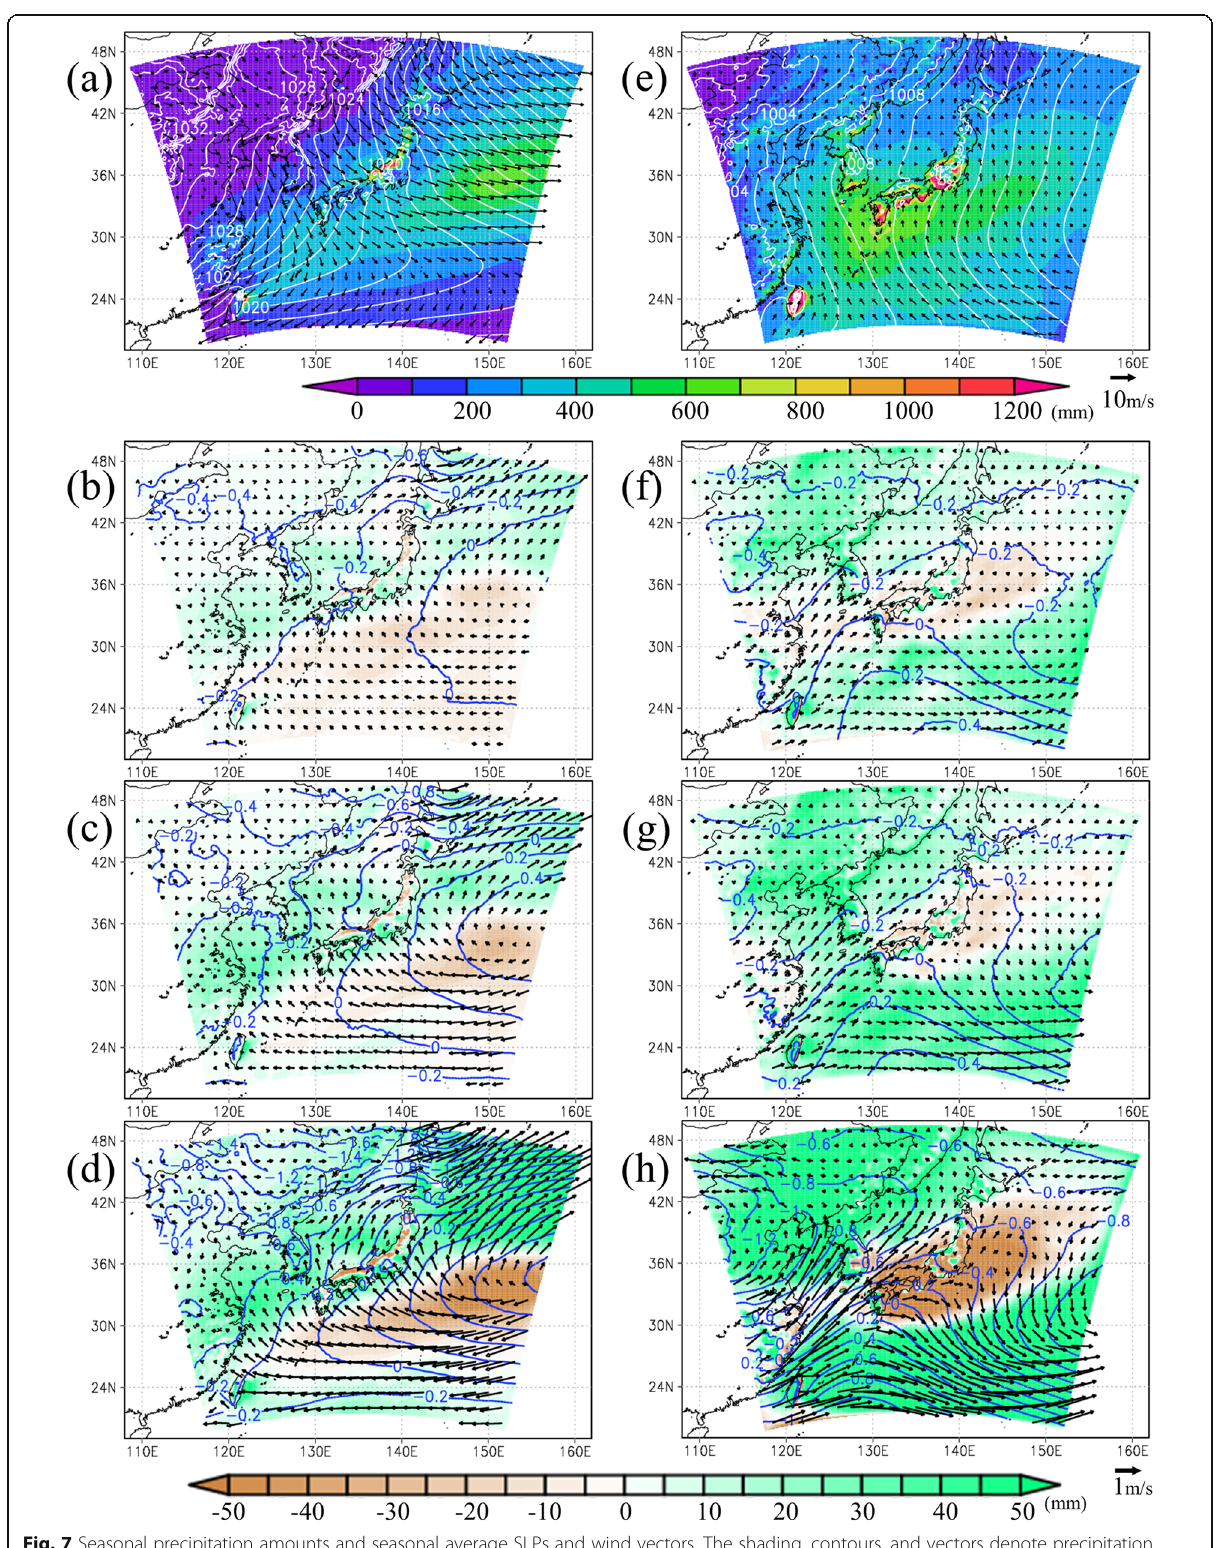
Fig. 7 Seasonal precipitation amounts and seasonal average SLPs and wind vectors. The shading, contours, and vectors denote precipitation amounts (mm), SLPs (hpa), and wind vectors (ms − 1 ), respectively, for ( a , b , c , and d ) DJF and ( e , f , g , and h ) JJA. a and e show the climatologies of PAST and the future changes of ( b and f ) d1.5, ( c and g ) d2, and ( d and h ) d4 are